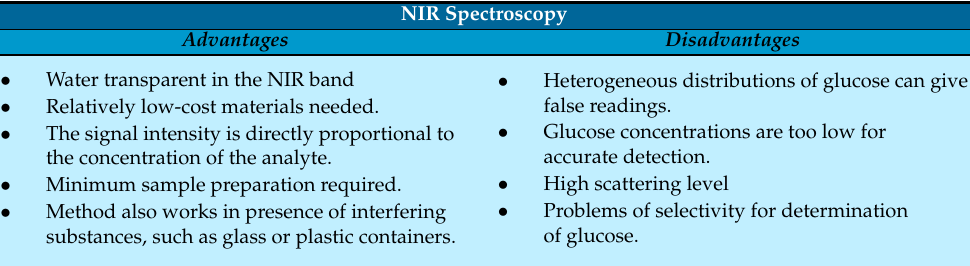
Table 9. Advantages and disadvantages of NIR spectroscopy.